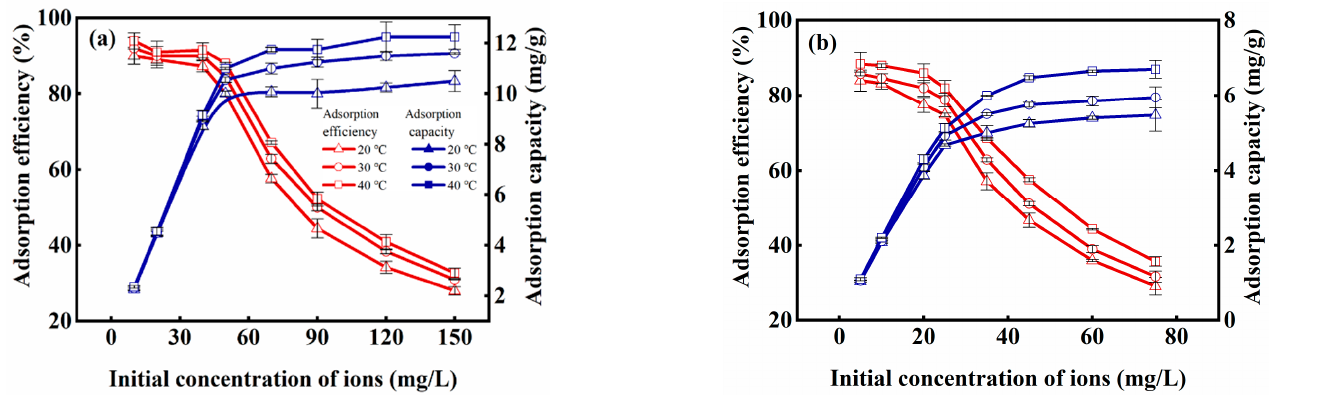
Figure 8. The effect of initial concentration and temperature on adsorption effect: ( a ) Pb ion; ( b ) Cd ion.